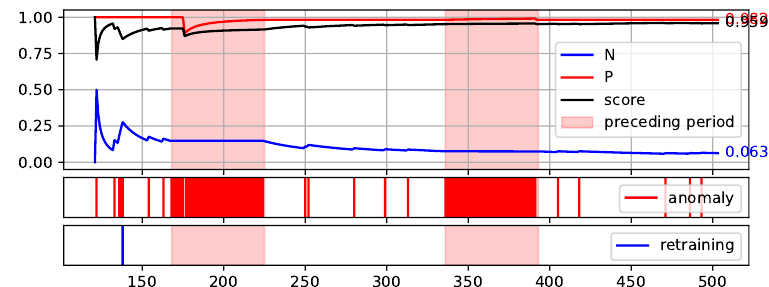
Figure 12. Plot of the values of each measure (P, N, and Score) over consecutive aggregation windows for HDBSCAN execution on the synthetic data